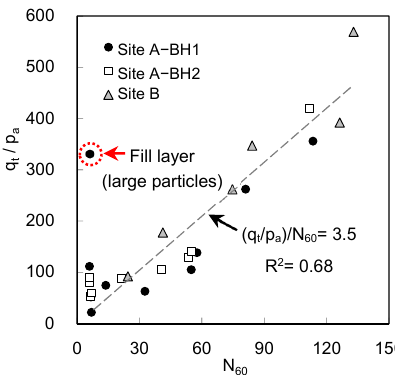
Figure 16. Comparison of the average total cone resistance obtained at each depth using ICP with N value measured from SPT. The p a denotes the reference stress of 100 kPa.